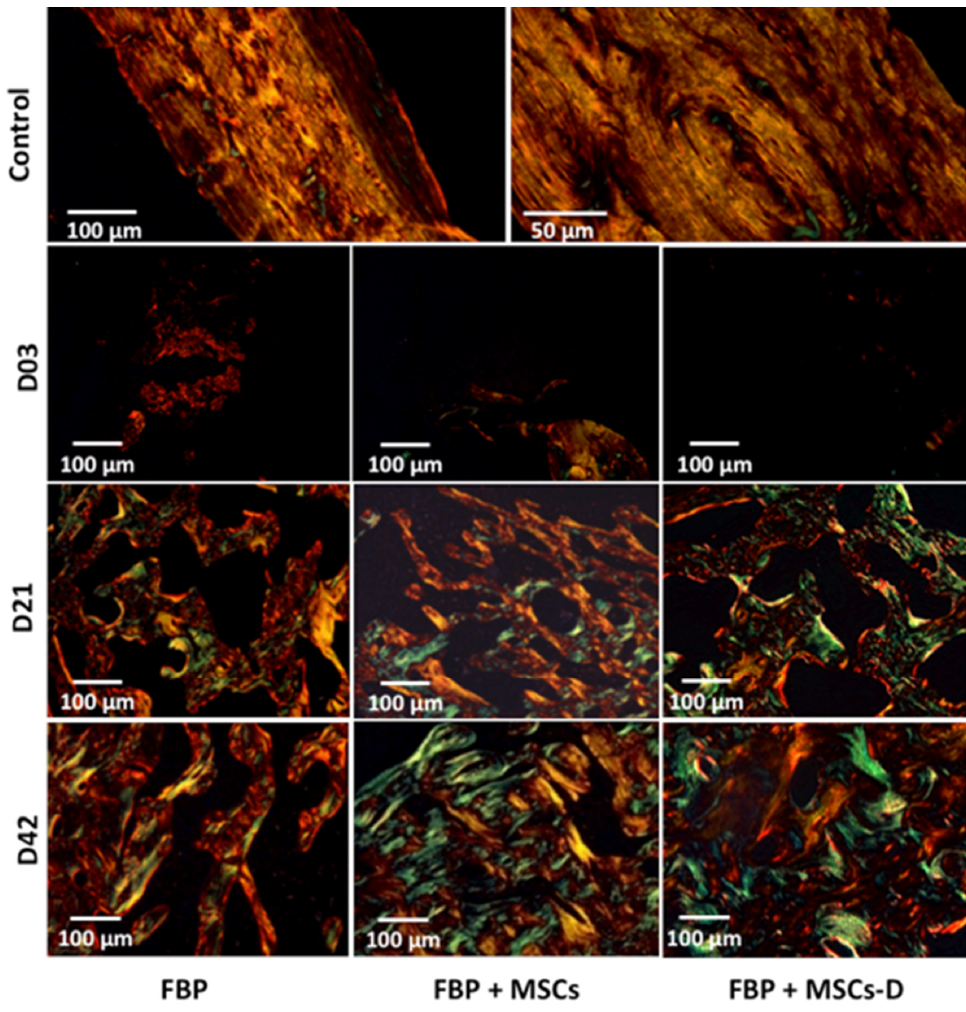
Figure 5. Picrosirius staining under polarized light showing collagen formation in injury filling in femur of rats at 3, 21 and 42 days post injury. FBP (fibrin biopolymer only); FBP + MSCs (fibrin biopolymer + mesenchymal stem cells); FBP + MSC-D (fibrin biopolymer + differentiated mesenchymal stem cells). Control shows a non-injured bone for comparison.